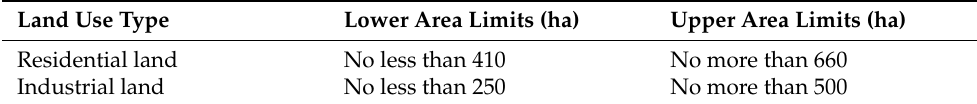
Table 4. Regional area constraints for residential and industrial land use in hectares (ha). Land Use Type